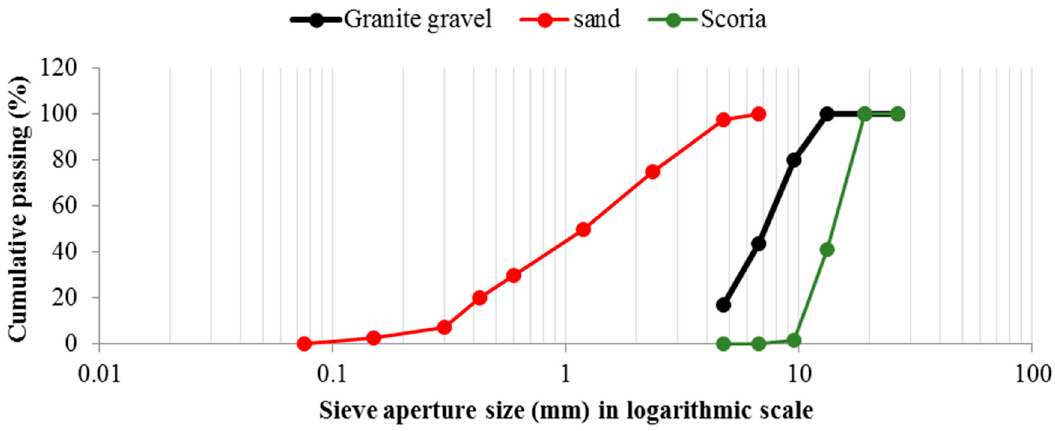
Figure 13. The size distribution of the aggregates.